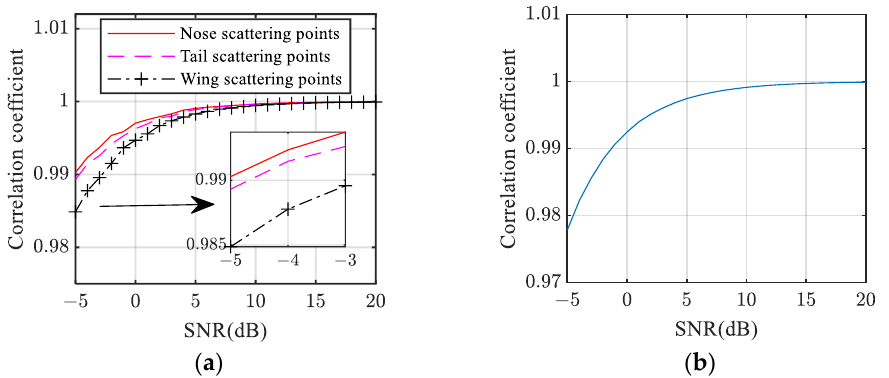
Figure 7. Correlation coefficients at different SNRs: ( a ) Correlation coefficients of specific scattering points; ( b ) Correlation coefficient of the whole image.